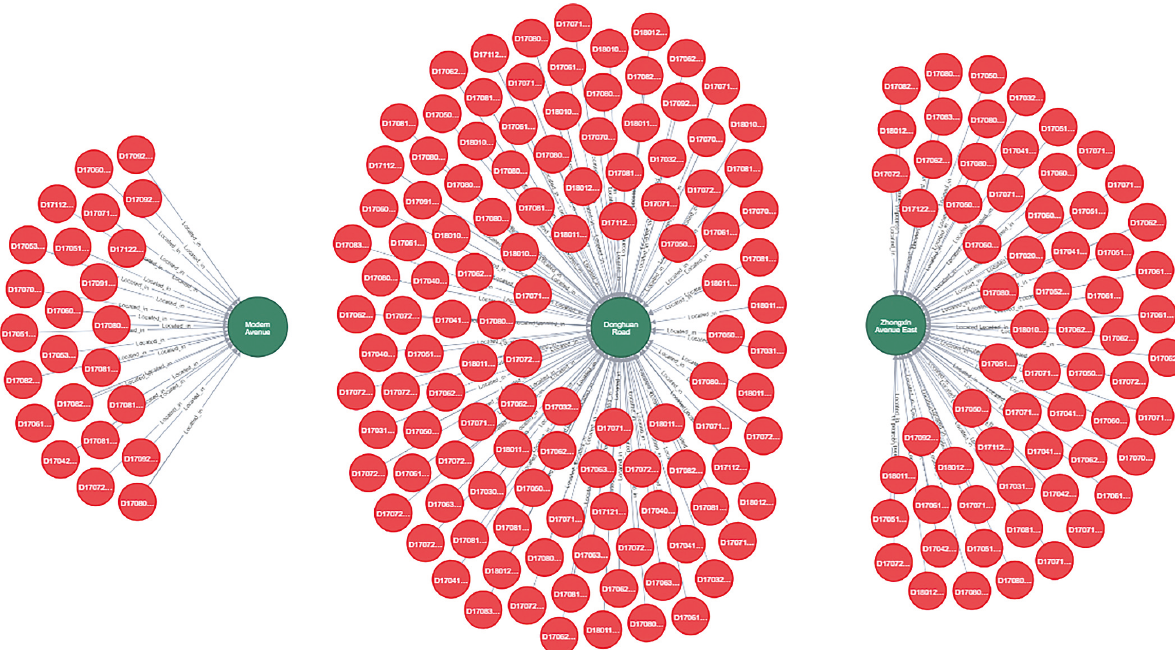
Figure 9: Visual display of accident classification by